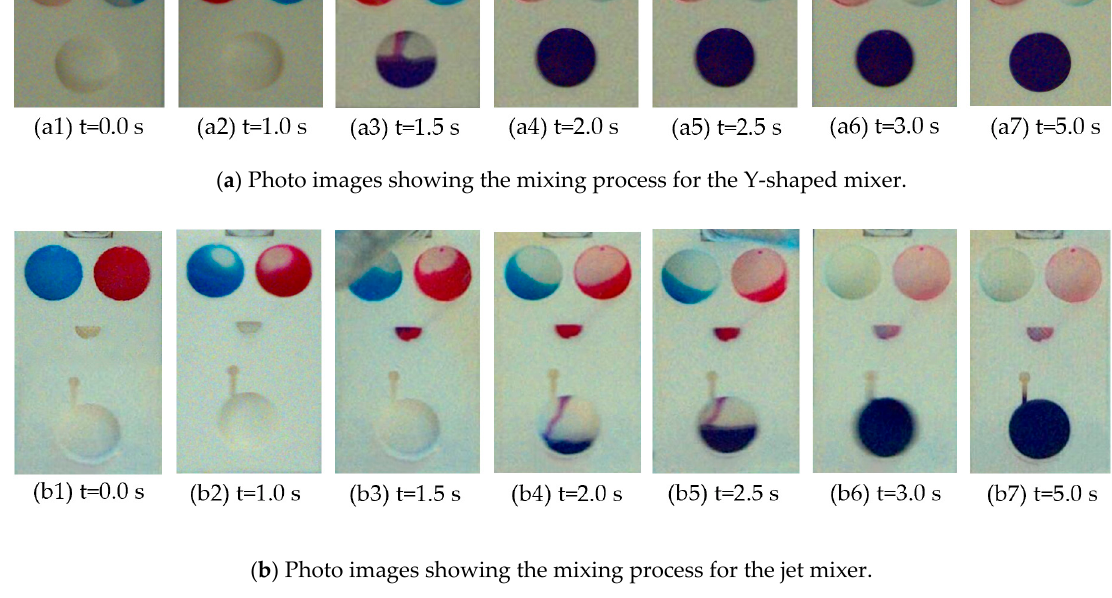
( b ) Photo images showing the mixing process for the jet mixer.